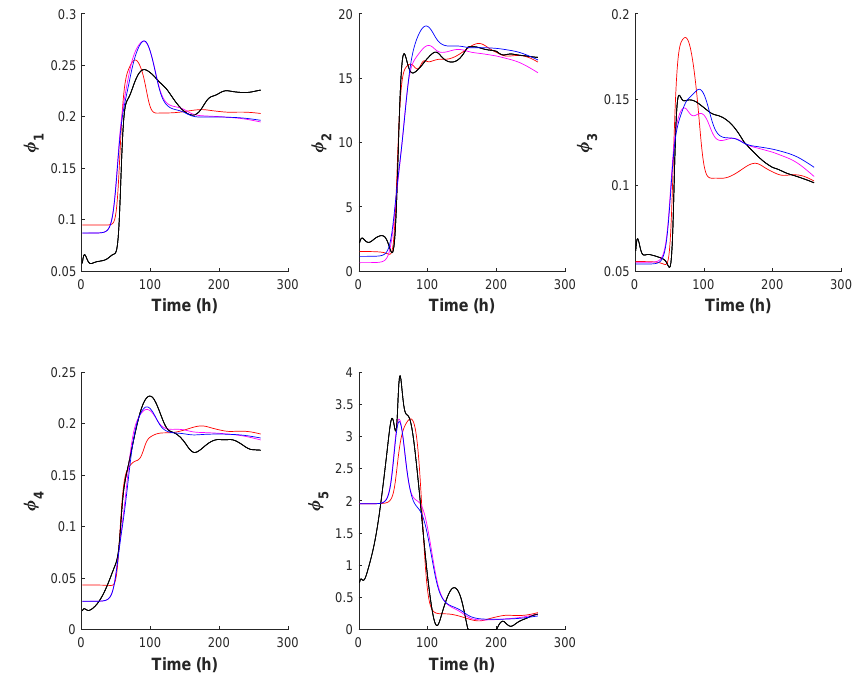
Figure 11. Time evolution of the specific reaction rates (in mM · h − 1 ) in dataset # 2—target values (black curves); prediction with MLP with three neurons in the hidden layer (red curves), and with three neurons and nonlinear re-identification of weights and biases (magenta curves); pruned MLP with three neurons (blue curves).